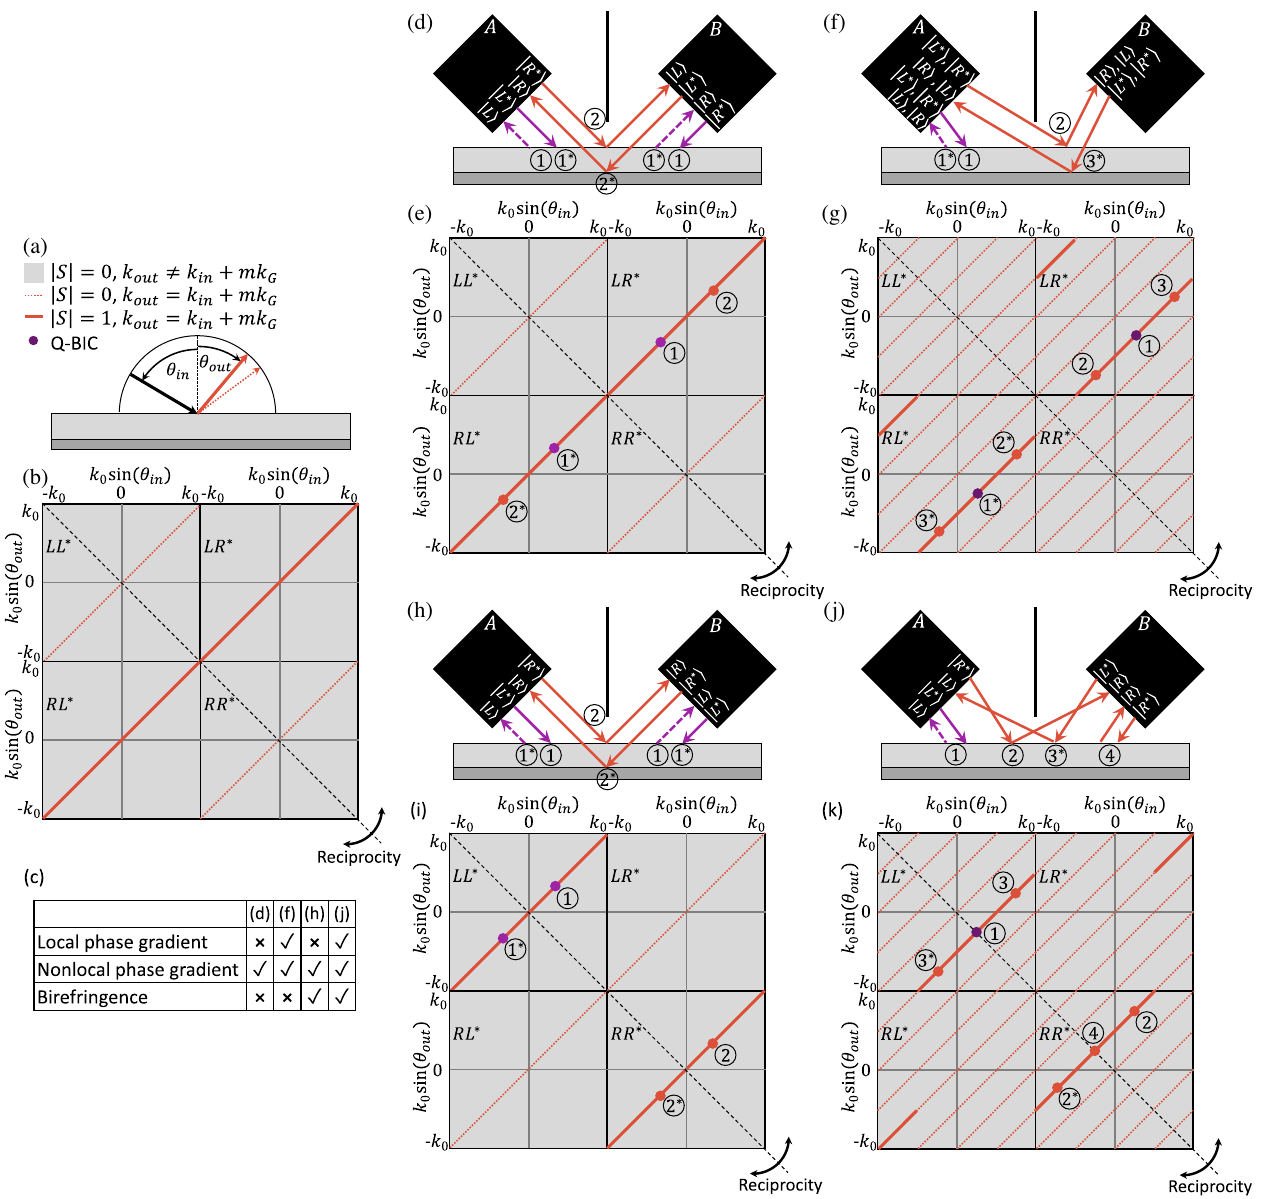
FIG. 5. Reciprocity and spin-selective unidirectionality. (a) Definitions and conventions for the continuous scattering matrices as in (b), which depicts the behavior of a specular mirror (which conserves linear momentum and flips the spin upon reflection). (c) Summary of the behavior of the four devices studied in (d) – (k). (d) Schematic showing two blackbodies, A and B , exchanging energy through a locally specular mirror with a nonlocal QBIC, depicted in (e) as a purple dot placeable anywhere along the specular response (solid orange line) via a nonlocal phase gradient. Reciprocity (symmetry about the black dashed line) forbids the existence of unidirectional emission. Similarly, (f) and (g) show the case of a local phase gradient but no nonlocal phase gradient, enabling unidirectional emission but not spin selectivity. To achieve spin selectivity, birefringence must be added, shown in (h) and (i) for the case of a birefringence local response with only a nonlocal phase gradient. However, reciprocity forbids unidirectionality except at normal incidence in this case. Finally, (j) and (k) show the case with a local phase gradient, nonlocal phase gradient, and birefringence, enabling spin-selective unidirectional thermal